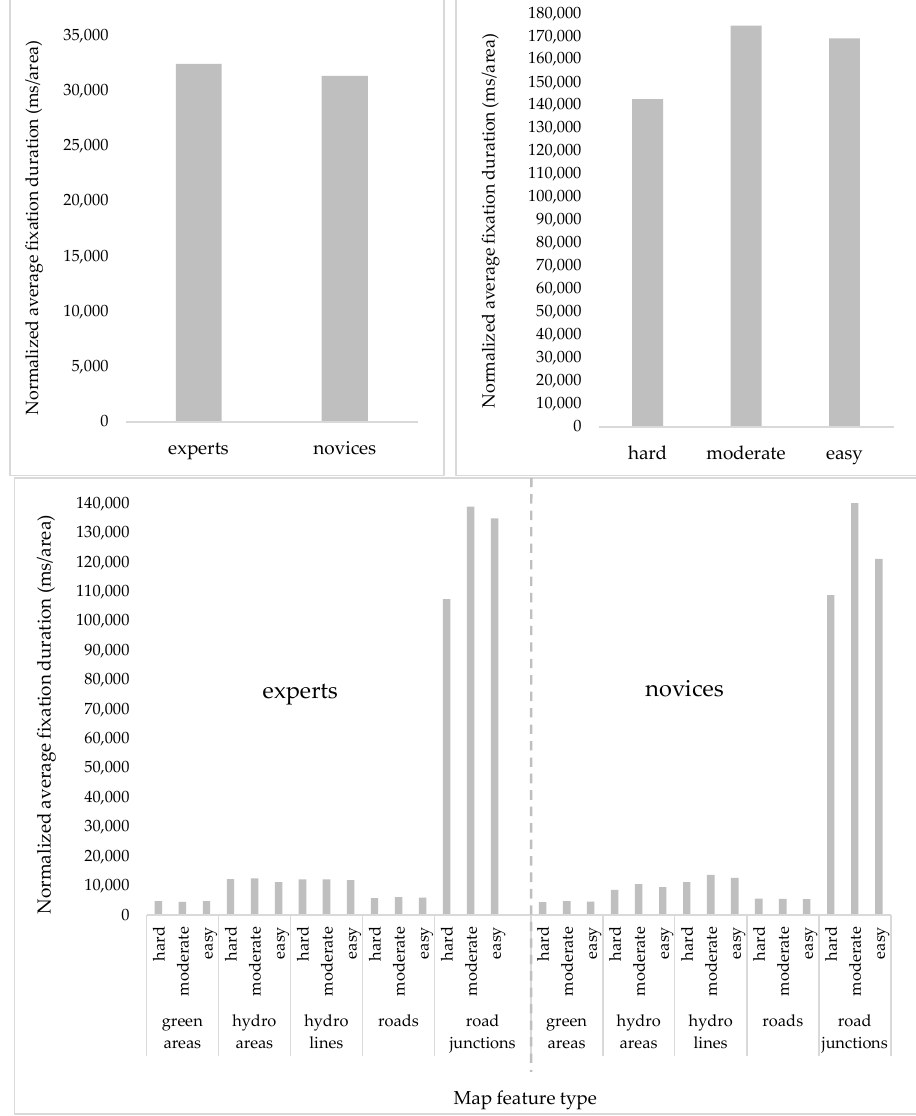
lines), and (iv) task difficulty (hard, moderate, easy). Table 3. Interaction effects of independent variables and within- vs. outside AOI analysis. Interactions